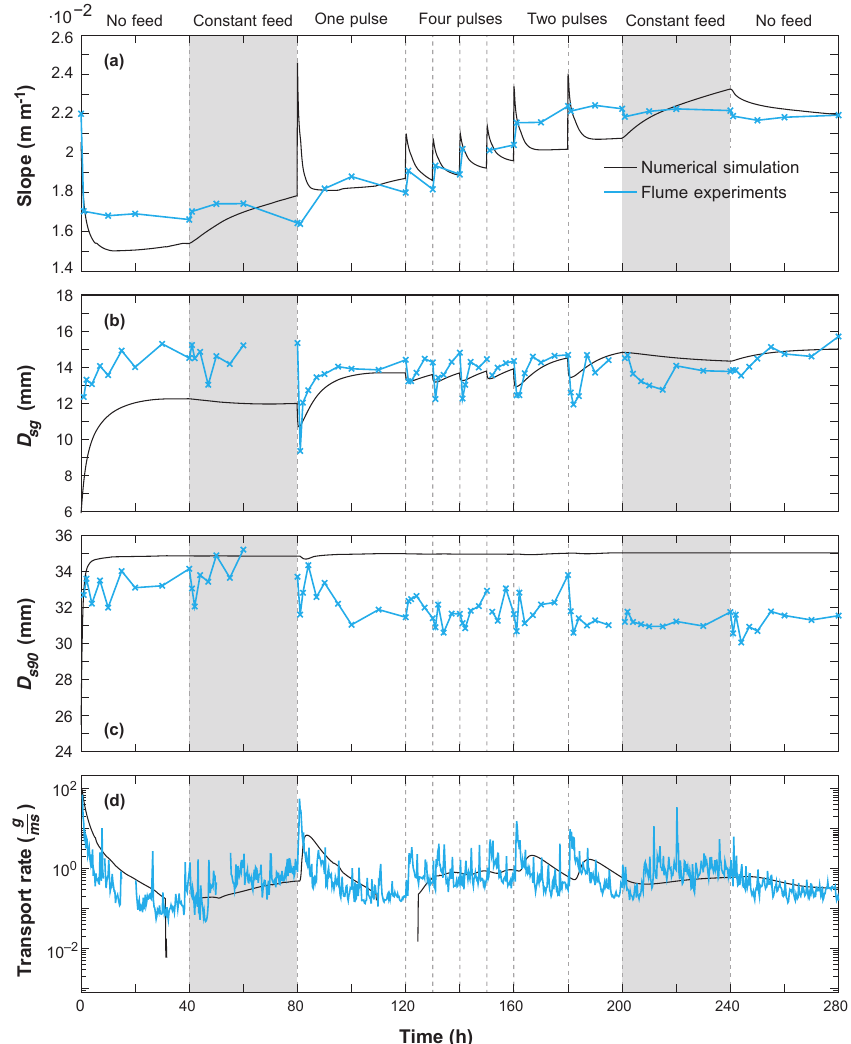
Figure 3. Comparison of (a) slope, (b) mean surface D sg , (c) surface D s90 , and (d) sediment transport rate between the numerical simulation and the flume